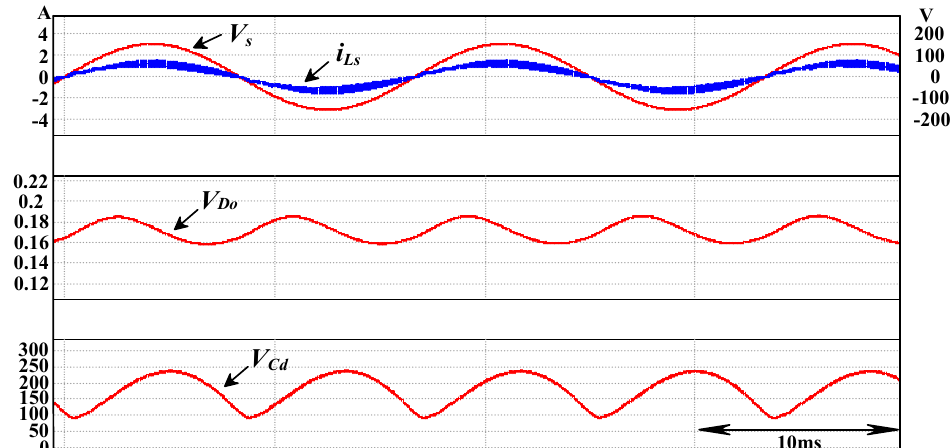
Figure 20. Simulation results for (top) the input voltage V s , current i s , (middle) the control signal V Do with high parameter value, and (bottom) corresponding intermediate capacitor voltage.